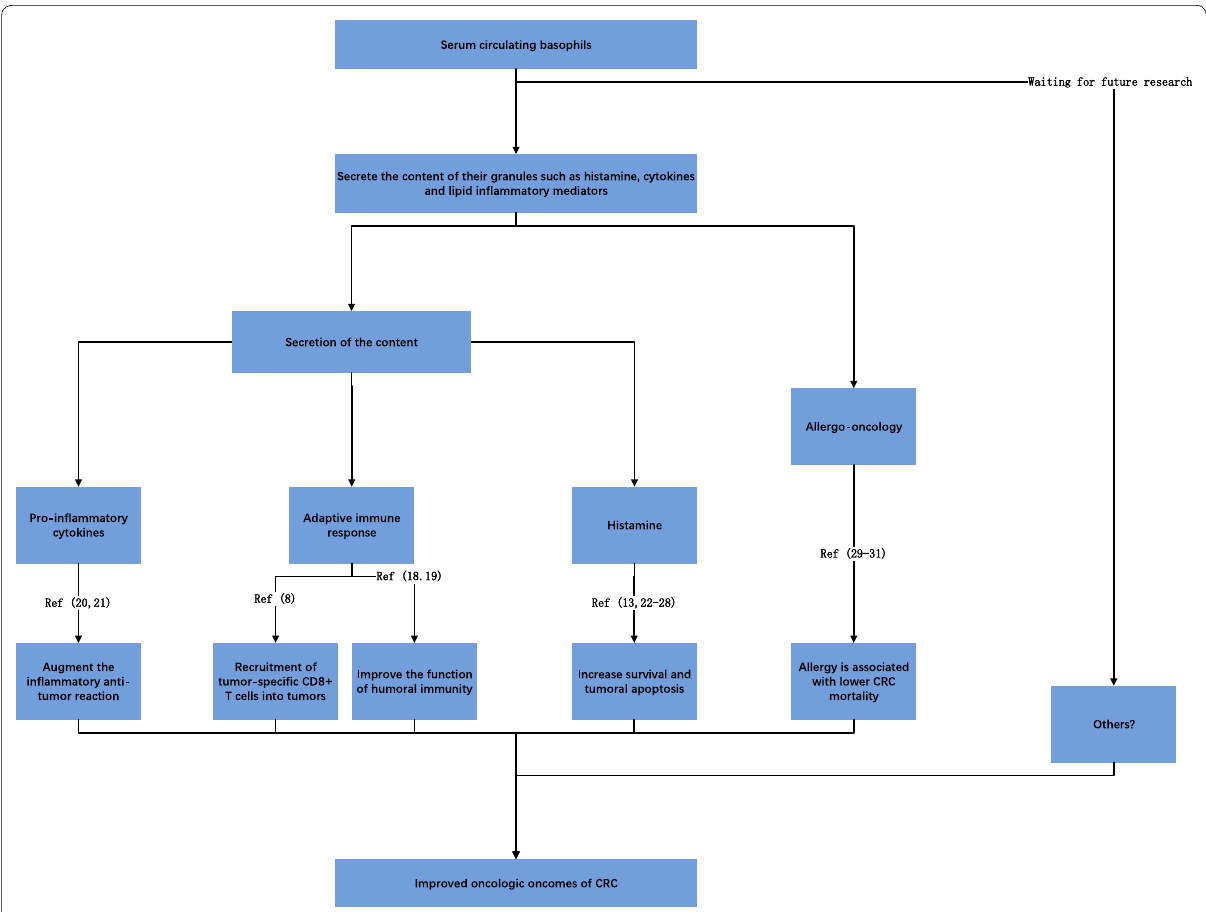
Fig. 4 Schematic representation of the reasons for better oncologic outcome of CRC patients with high-level basophils